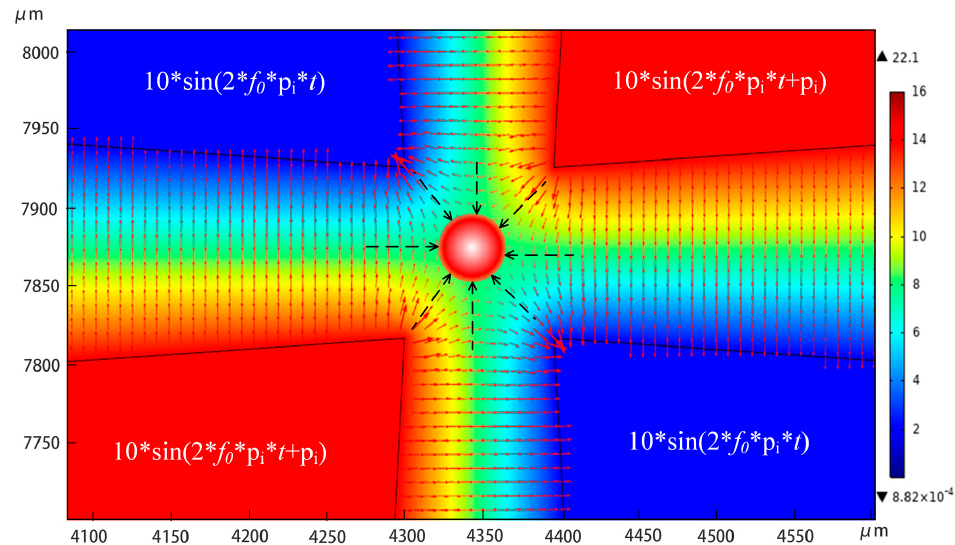
Figure 5. Electric field intensity simulation of particle capture (V/m).